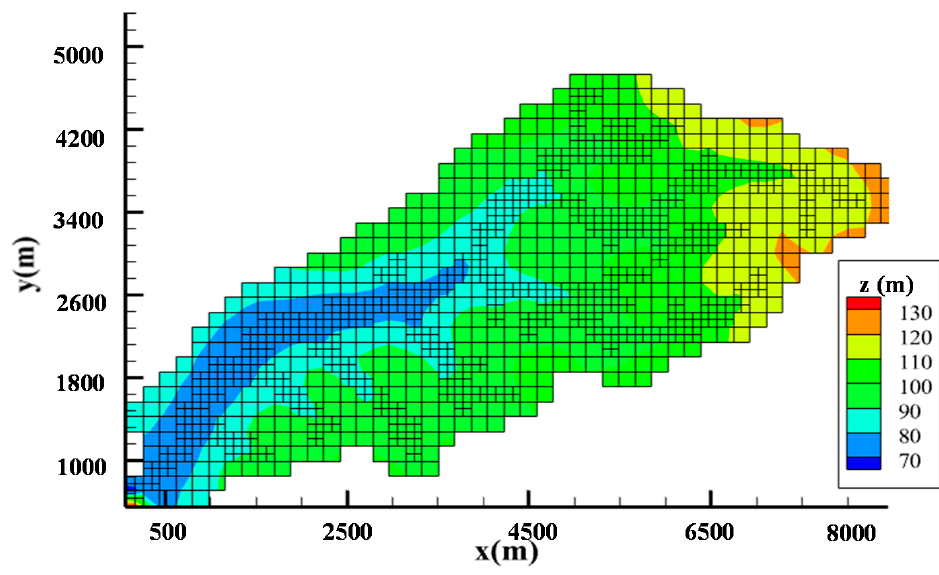
Figure 19. The gird partition of the Goodwin Creek Experimental Watershed.